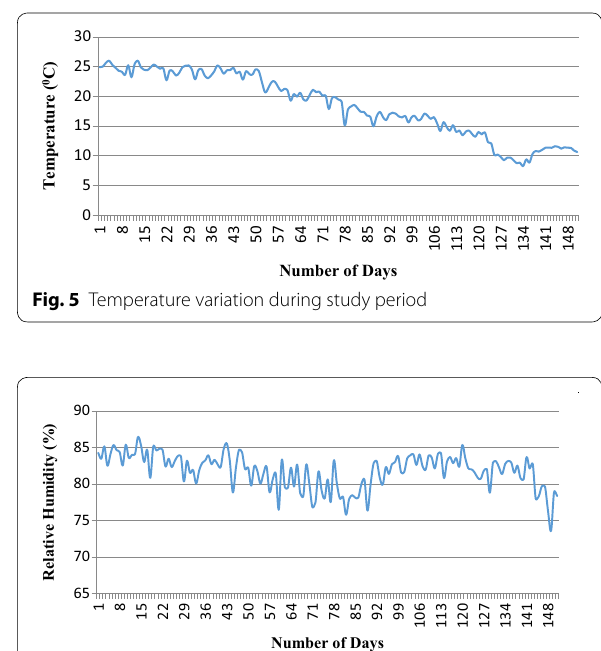
Fig. 6 Average humidity for the study period